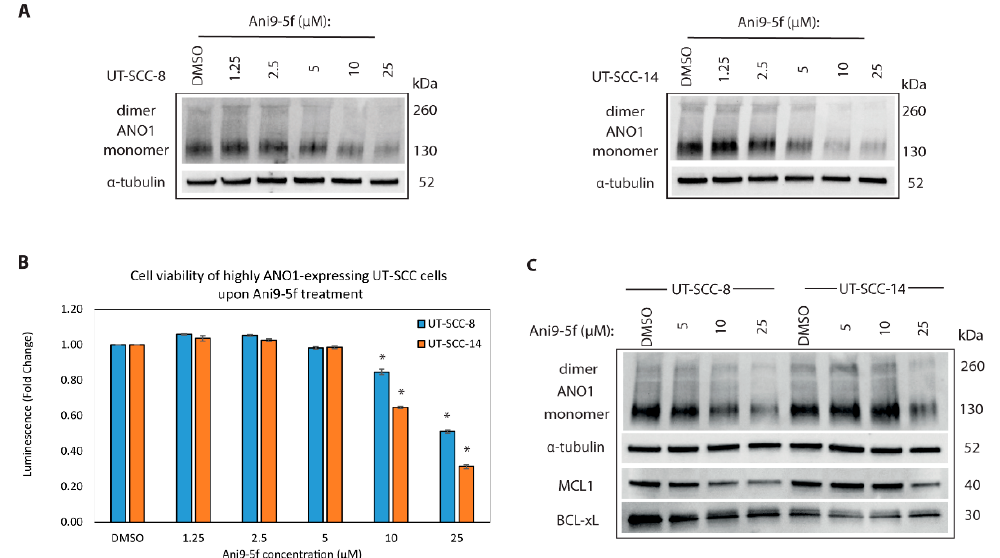
Figure 5. Pharmacological inhibition of ANO1 decreases cell viability and suppresses protein levels of ANO1, MCL1, and BCL-XL. ( A ) Western blots showing the decreasing ANO1 protein levels in UT-SCC cells, upon treatment with Ani9-5f for 48 h in a concentration-dependent manner. Alpha-tubulin is the loading control. ( B ) Bar plot illustrating the response of ANO1 HIGH UT-SCC cell lines to Ani9-5f small-molecule inhibitor, as measured by cell viability (Cell Titer Glow ® ), * p -value < 0.05. ( C ) Western blot panels indicate the differential protein levels of ANO1, MCL1 and BCL-XL upon treatment of UT-SCC-8 and UT-SCC-14 with the indicated concentrations of Ani9-5f. Alpha-tubulin is the loading control.